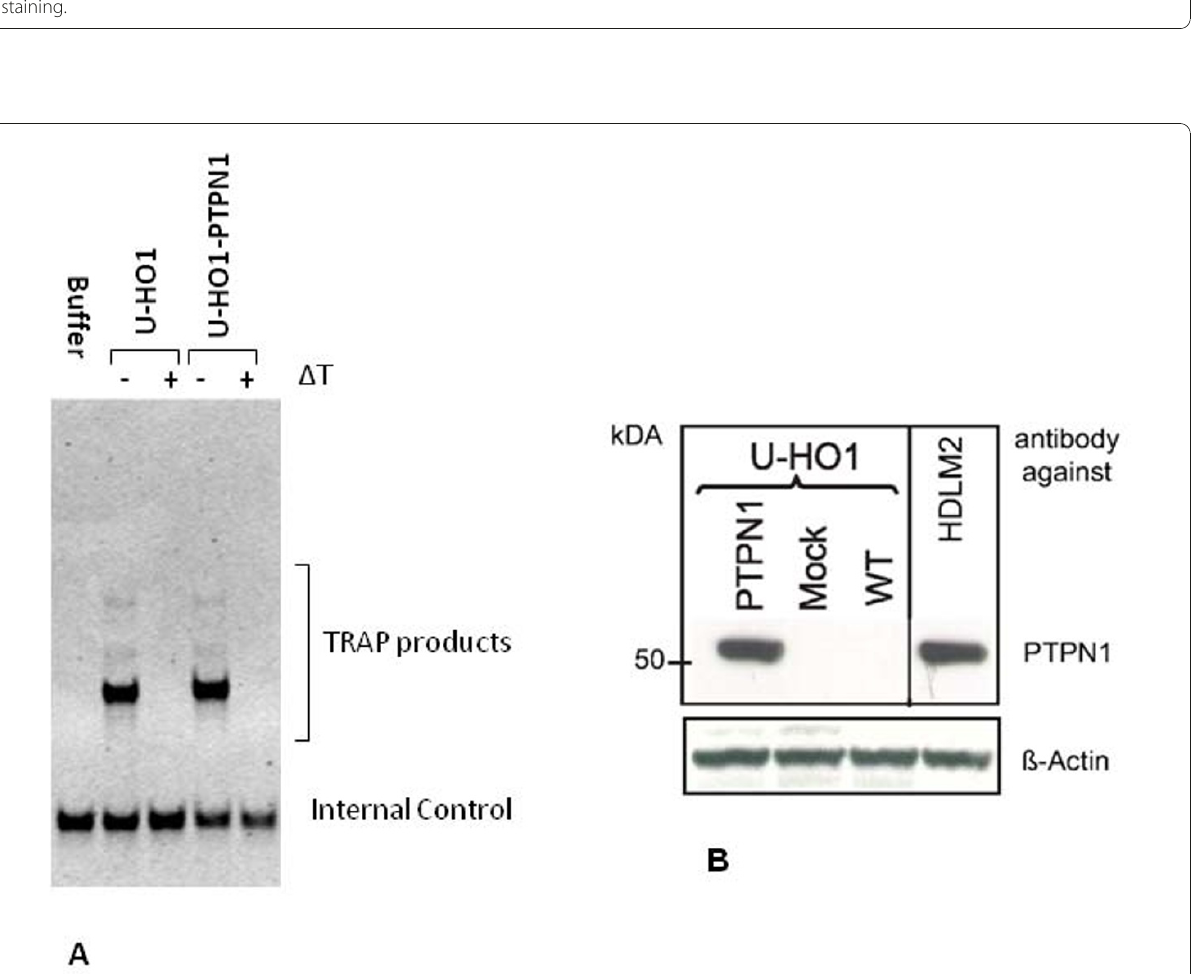
Figure 1 PTPN1 expression promotes multinuclearity . Multinuclear RS-cells in U-HO1-mock (A) and U-HO1-PTPN1 (B). May-Grünwald-Giemsa staining.